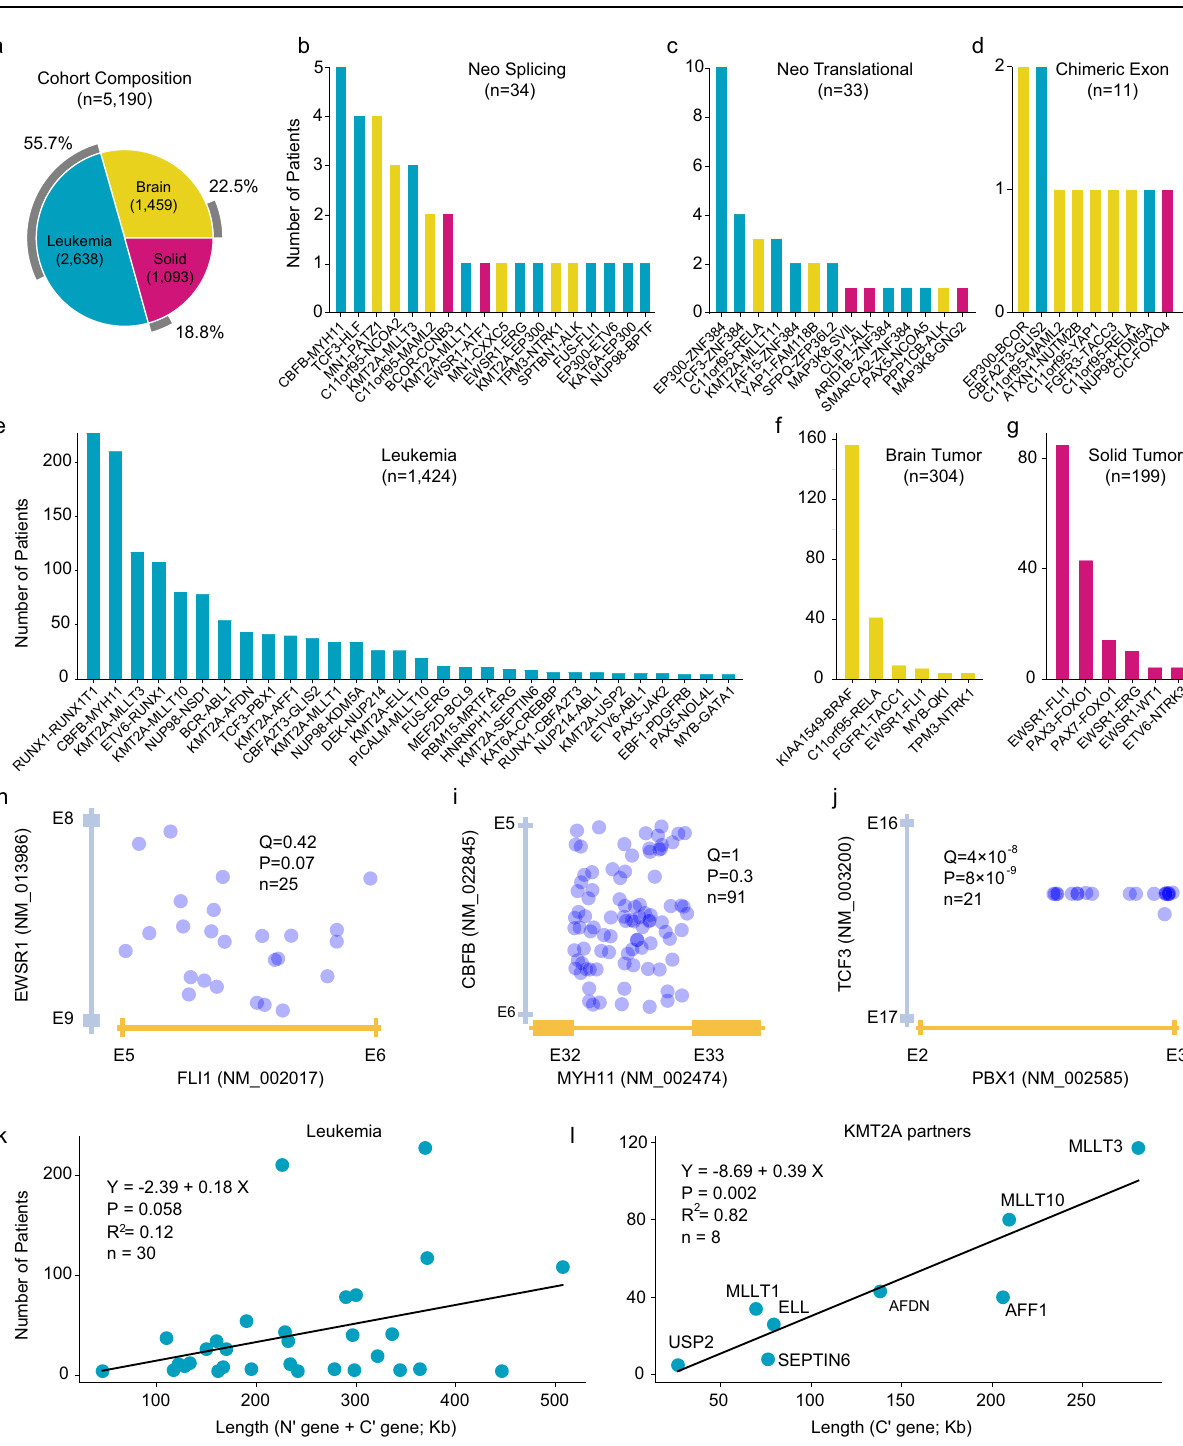
Fig. 2 | Fusion landscape in childhood cancers. a Cohort composition. We ana- lyzed 2638 leukemia (blue), 1459 brain tumors (yellow), and 1093 solid tumors (magenta), totaling 5190 childhood cancer patients. Percent patient tumors with oncogenic fusion detected are indicated with gray rings. b – d Spectrum of neo- splicing ( b ), neo-translational ( c ) and chimeric exon ( d ) fusions. e – g Spectrum of canonical fusions in leukemia ( e ), brain tumor ( f ) and solid tumor ( g ). In panels b – g ,barsarecolor-codedaccordingtotumortypesinpanel a .DistributionofDNA breakpoints (light blue dots) for oncogenic fusions is uniformly distributed in corresponding intronic regions for EWSR1 - FLI1 ( h ) and CBFB - MYH11 ( i ), but not for